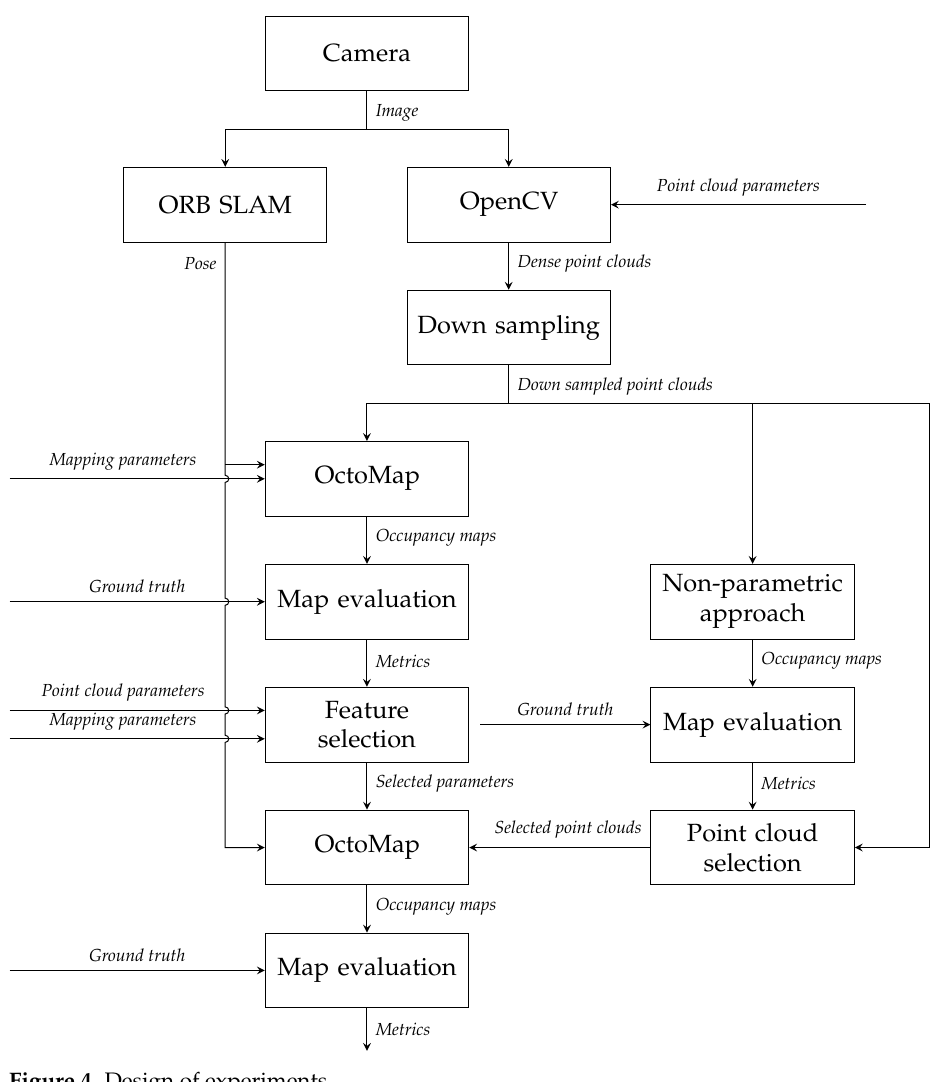
Figure 4. Design of